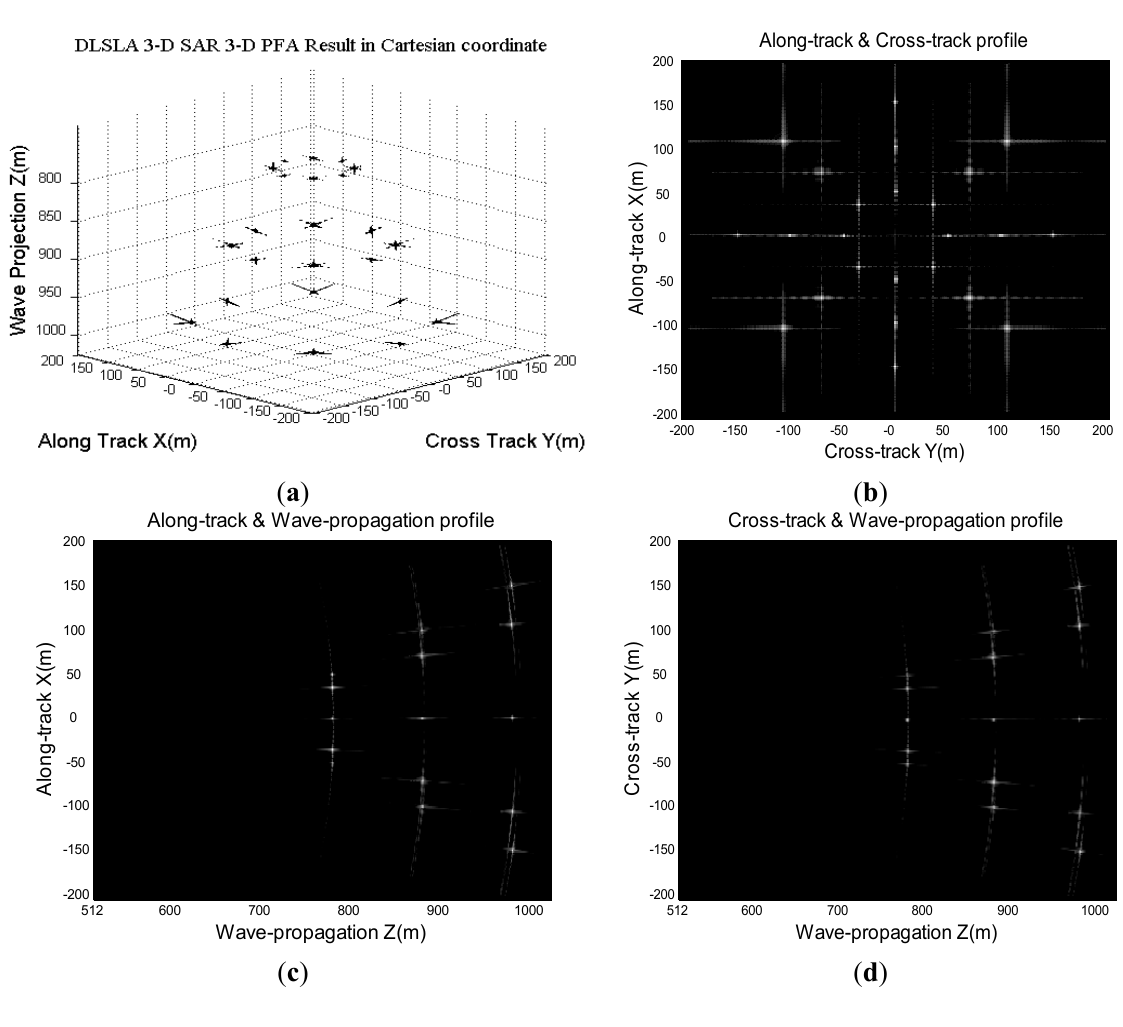
Figure 14. Imaging result in Cartesian coordinate grid: ( a ) 3-D imaging result. ( b ) Image projected onto XY plane. ( c ) Image projected onto XZ plane. ( d ) Image projected onto YZ